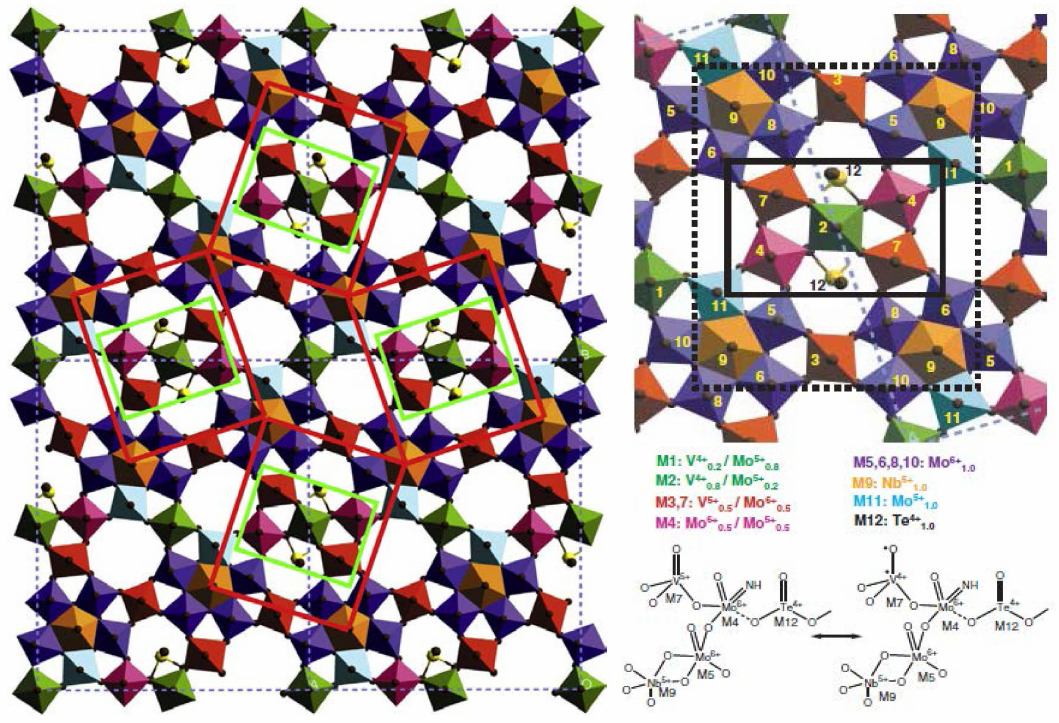
Figure 7. Active site ( left ) in Mo 7.8 V 1.2 NbTe 0.94 O 28.9 (M1): 2 ˆ 2 unit cell structure model of M1 in (001) projection showing four isolated catalytically active centres. The site sites are isolated from each other by four Nb-bipyramids that are surrounded by five MO n -octahedra. ChemDraw depiction ( right ). Adapted from figures 15 & 16 in [8], copyright 2016, Elsevier